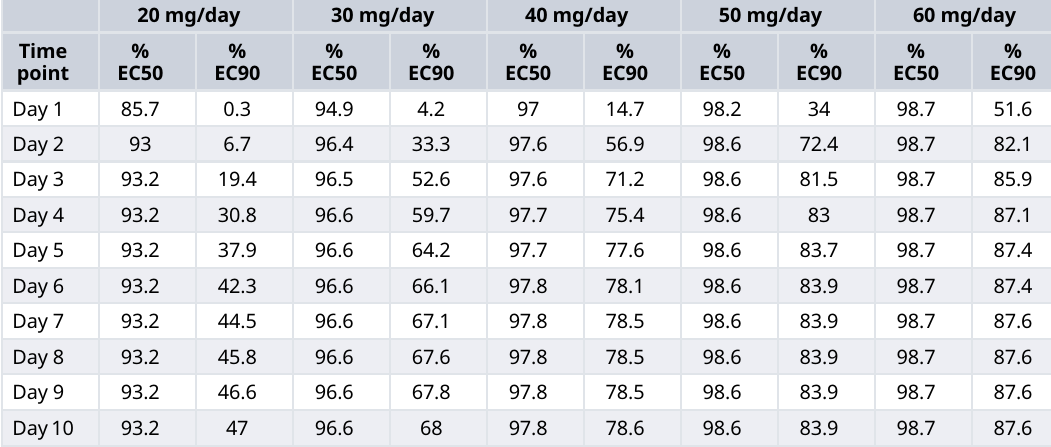
Table 2. Predicted SARS-CoV-2 pharmacodynamics showing the daily fluoxetine dose and corresponding percent of the population (n=1,000) achieving a trough plasma concentration of 4.7 ng/ml (EC50-plasma) and 23.2 ng/ml (EC90-plasma), which leads to 60-times higher lungs based on the target EC50 (283.6 ng/ml [0.82 μ M]) and EC90 (1390.1 ng/ml [4.02 μ M]) concentrations, during a treatment period of 10-days.